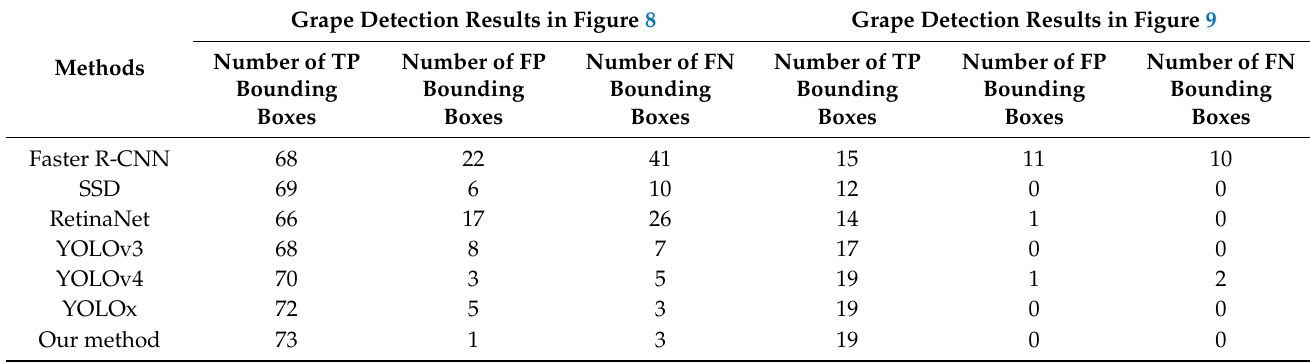
Table 9. The detection results on the WGISD and wGrapeUNIPD-DL using different methods. Grape Detection Results in Figure 8 Grape Detection Results in Figure 9